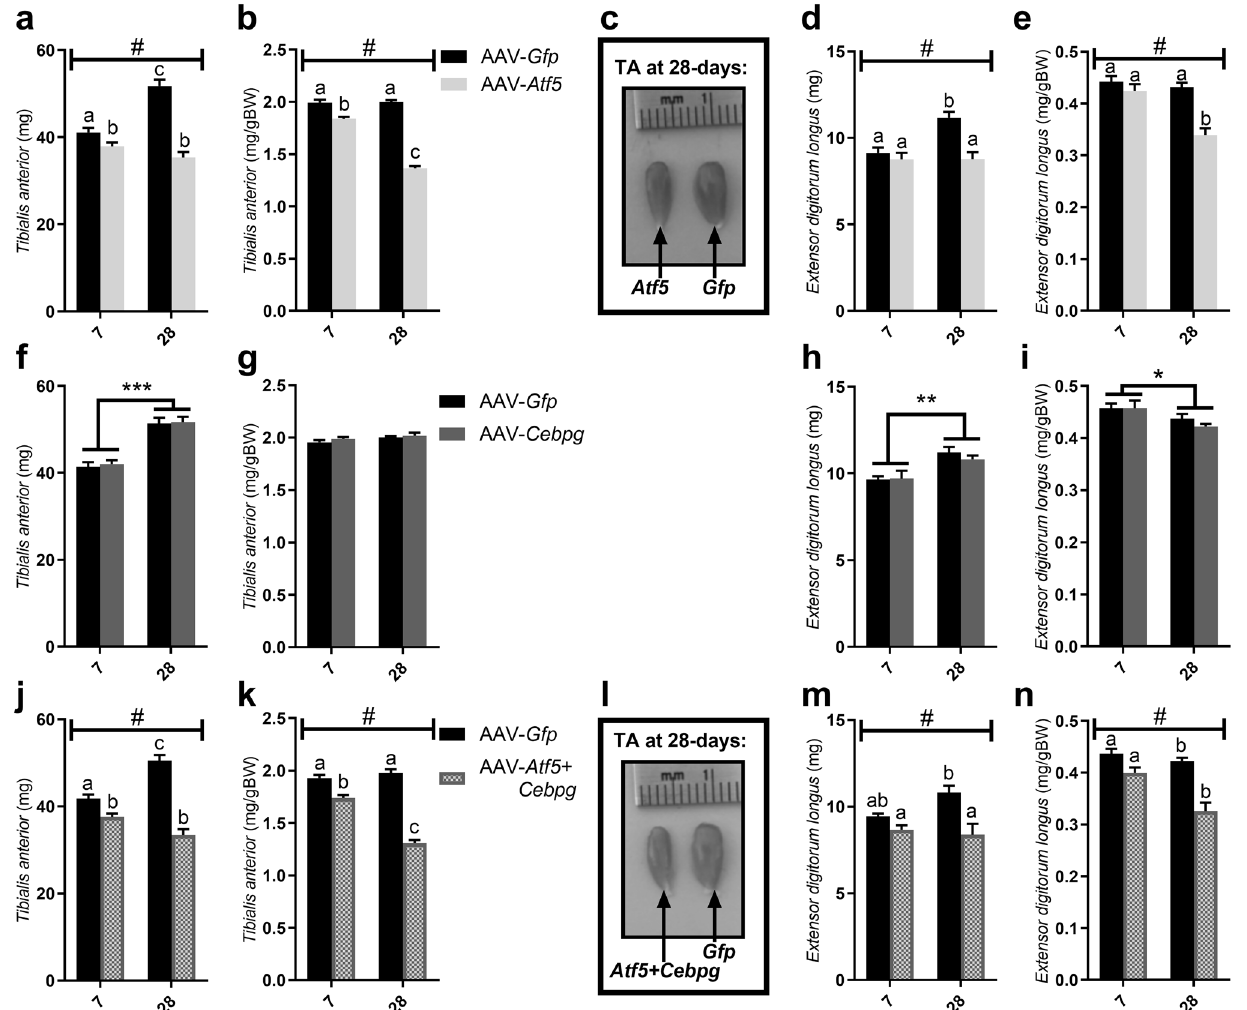
Figure 7. Effect of 7 and 28 days of AAV-mediated overexpression of Atf5 and Cebpg individually and in combination (AAV- Atf5 ± Cebpg ) on mouse muscle weights. Absolute and muscle weights relative to body weight (BW) for Tibialis anterior (TA; a / b , f / g , j / k ) and Extensor digitorum longus (EDL; d / e , h / i , m / n ) following 7 and 28 days of AAV-mediated overexpression of Atf5 ( a – e ), Cepbg ( f – i ) or both (AAV- Atf5 + Cebpg , j – n ). Representative photographs of TA muscle transduced with ( c ) AAV- Atf5 or ( l ) AAV- Atf5 + Cebpg and the contralateral control TA from the same animal transduced with AAV- Gfp for 28-days. Data presented as Means (n = 8) ± SEM. # indicates a significant AAV × time interaction ( P < 0.01). Different letters indicate significant differences ( P < 0.05). *( P < 0.05), **( P < 0.01) and ***( P < 0.001) indicate significant differences in muscle weights at day 28 compared to day